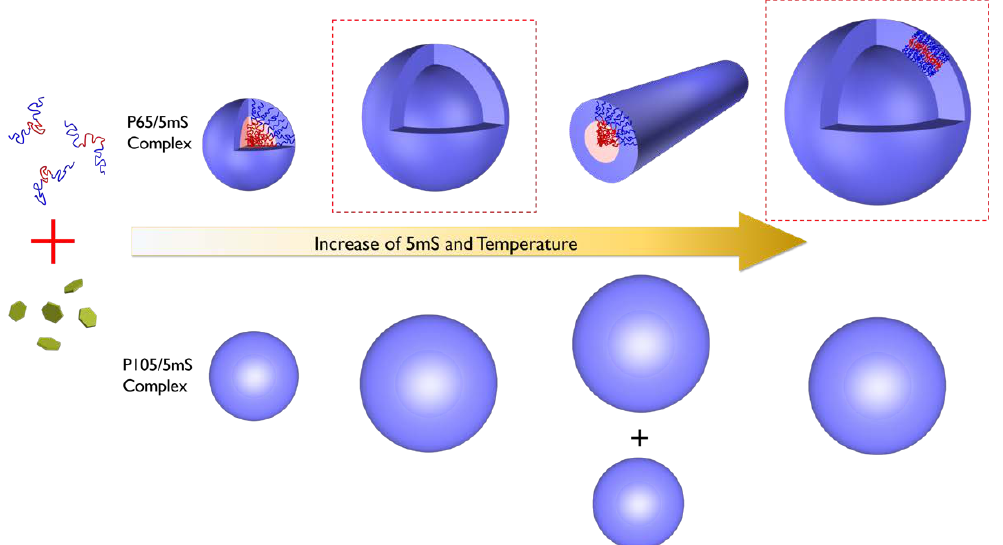
Figure 6. The schematics of the phase behavior of Pluronic polymer-5mS mixture depending on the 5mS concentration and temperature.